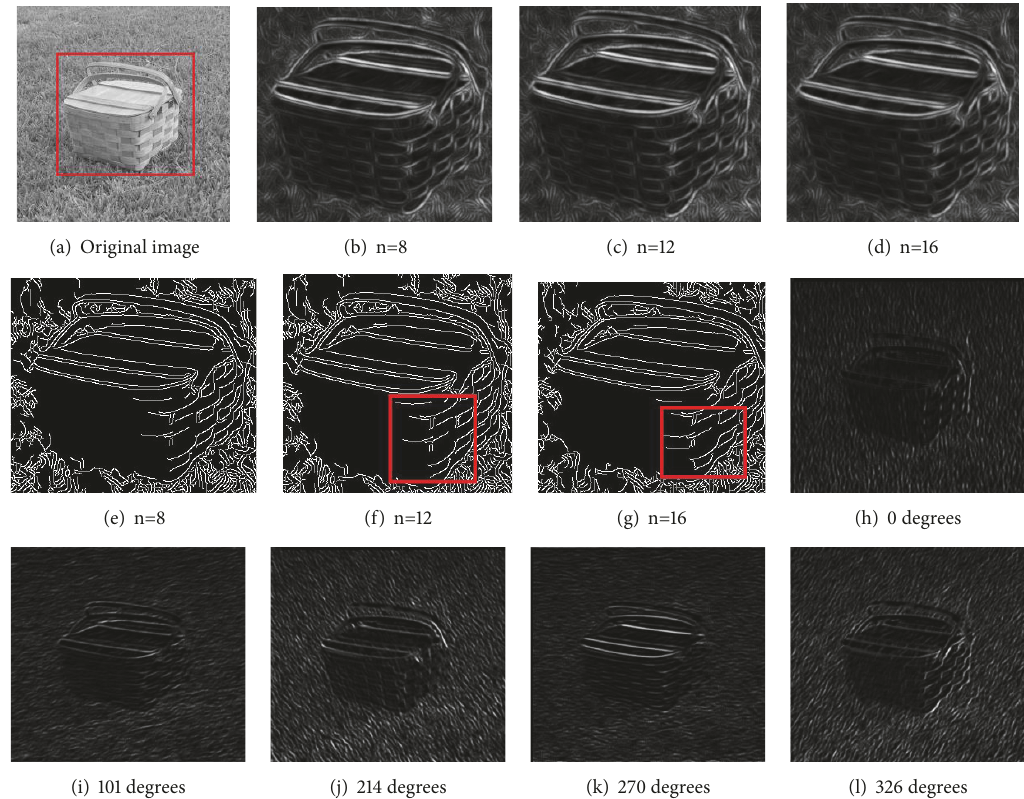
Figure 4: Selection of the appropriate parameter n and orientation comparison.